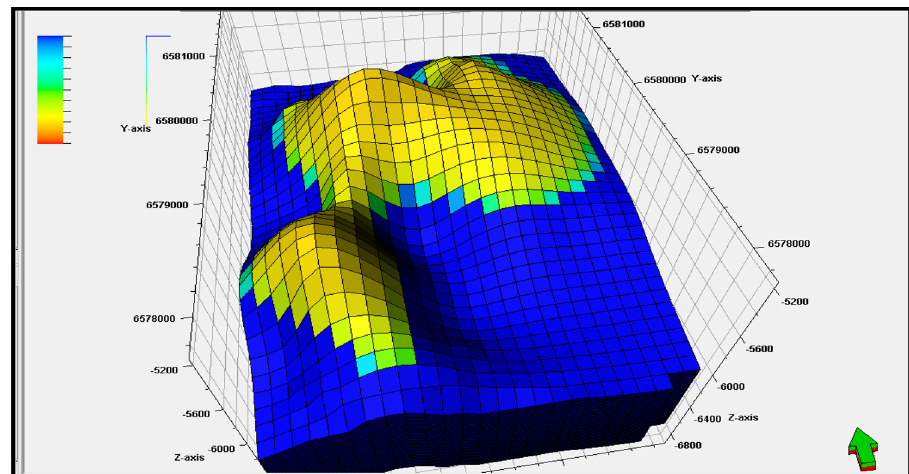
Fig. 5 a Poro-perm transformation plot. b Permeability model along the X direction Fig. 6 Water saturation